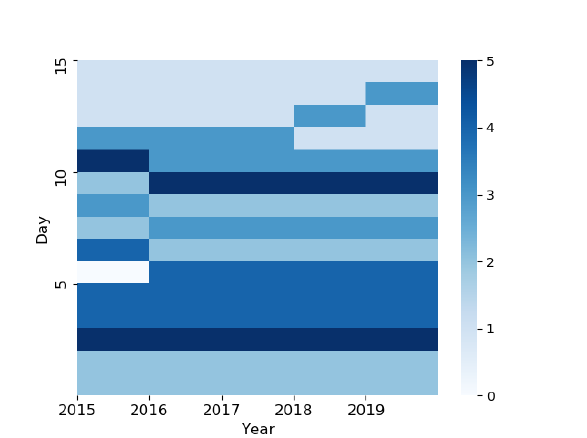
Figure 24: Clustering output for humidity for first 15 days in Q 2 over 2015 to 2019.